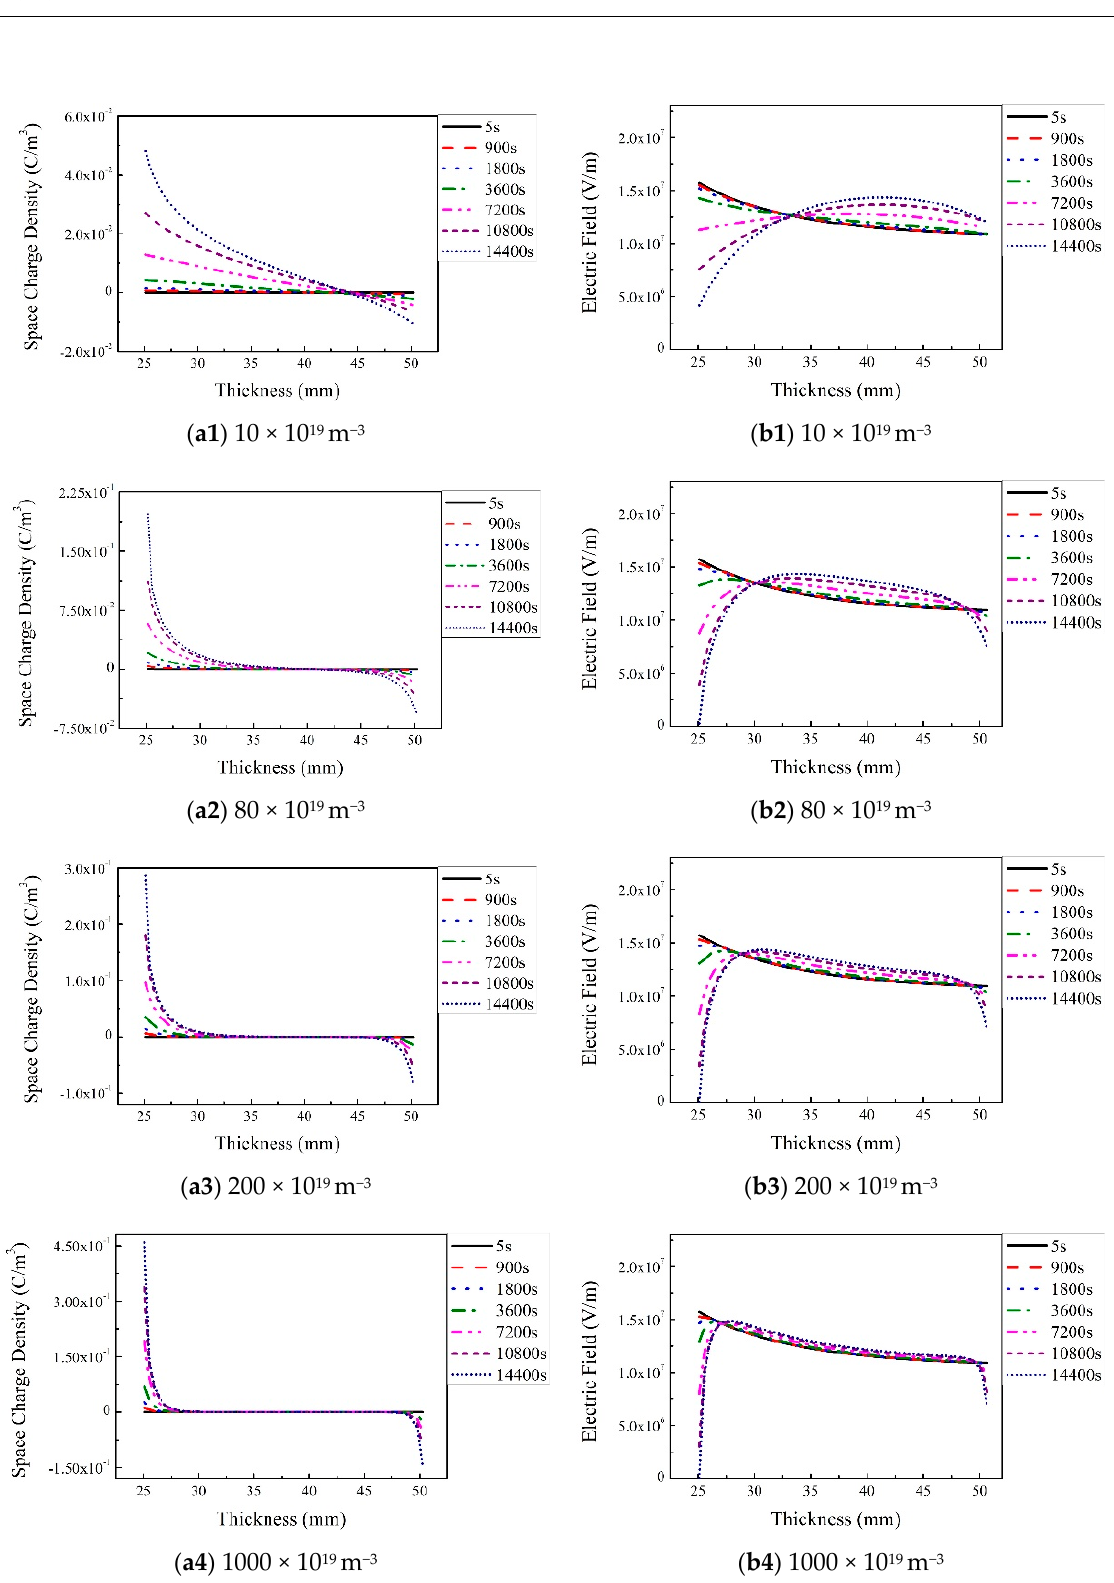
Figure 8. Simulation results of space charge distribution ( a1 – a4 ) and electric field distribution ( b1 – b4 ) in 320 kV HVDC cable insulation when the trap density varies from 10 × 10 19 m − 3 to 1000 × 10 19 m − 3 with the trap depth of 1.20 eV and load current of 1800 A.